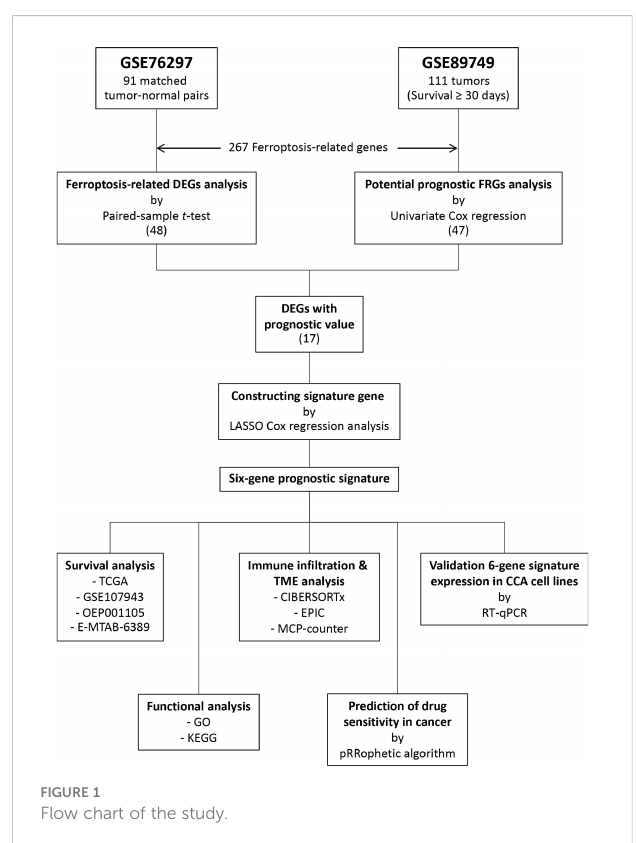
FIGURE 1 Flow chart of the